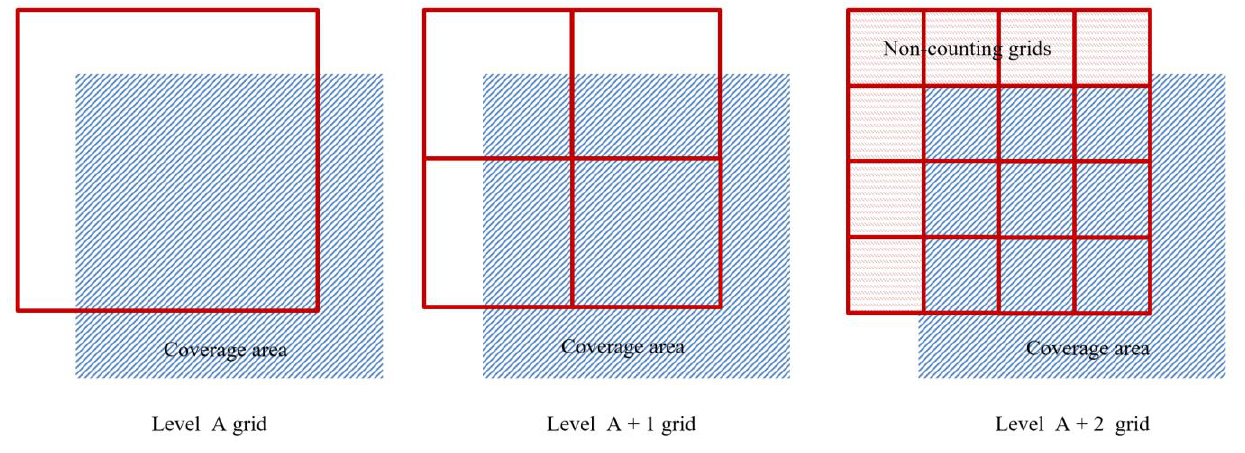
Figure 13. Effect of grid hierarchy on boundary representation.